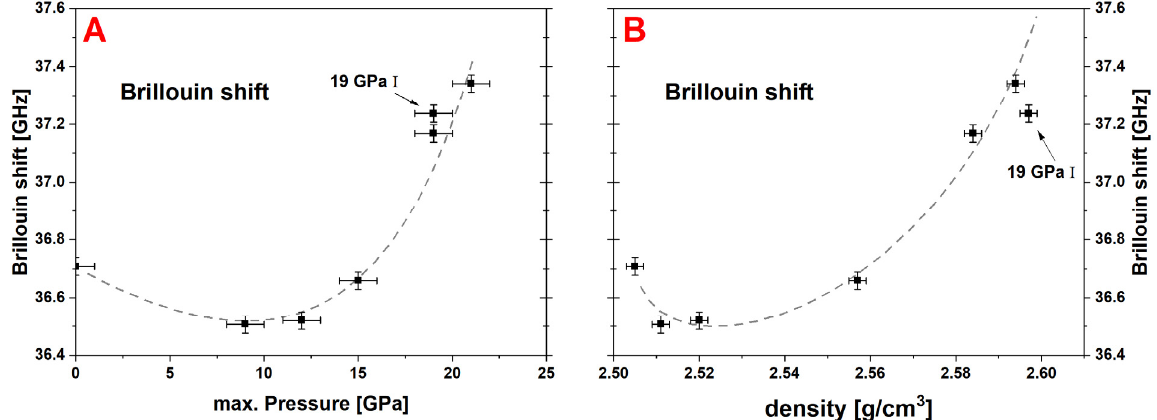
Figure 11. Evolution of the Brillouin shift of the permanently densified glass samples versus the maximum pressure ( A ) and the measured density ( B ); dashed gray lines are guide to the eye; a non-linear evolution is evident with a decrease of the Brillouin shift at moderate densification and a steady increase to the highest applied P max ; a similar behavior with a minimum of the elastic properties was observed on permanently densified amorphous silica, but not reported for soda–lime–silicate glass up to now.